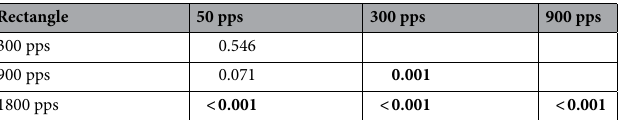
Table 1. Bonferroni corrected p-values for the null hypothesis that mean ITD sensitivities do not vary as a function of pulse rate for rectangular windowed stimuli with pps values shown in the row and column headings. Significant p-values (< 0.05) are shown in bold.